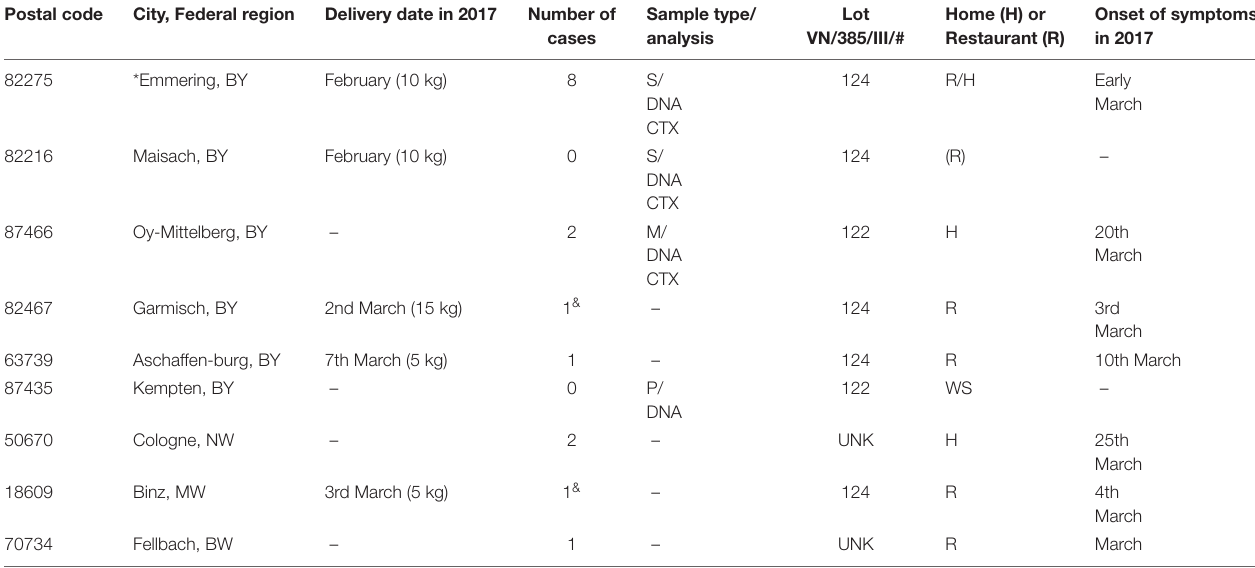
TABLE 1 | Ciguatera poisoning outbreak clusters that occurred in Germany in 2017 from imported fish labeled as “Red Snapper”. Postal